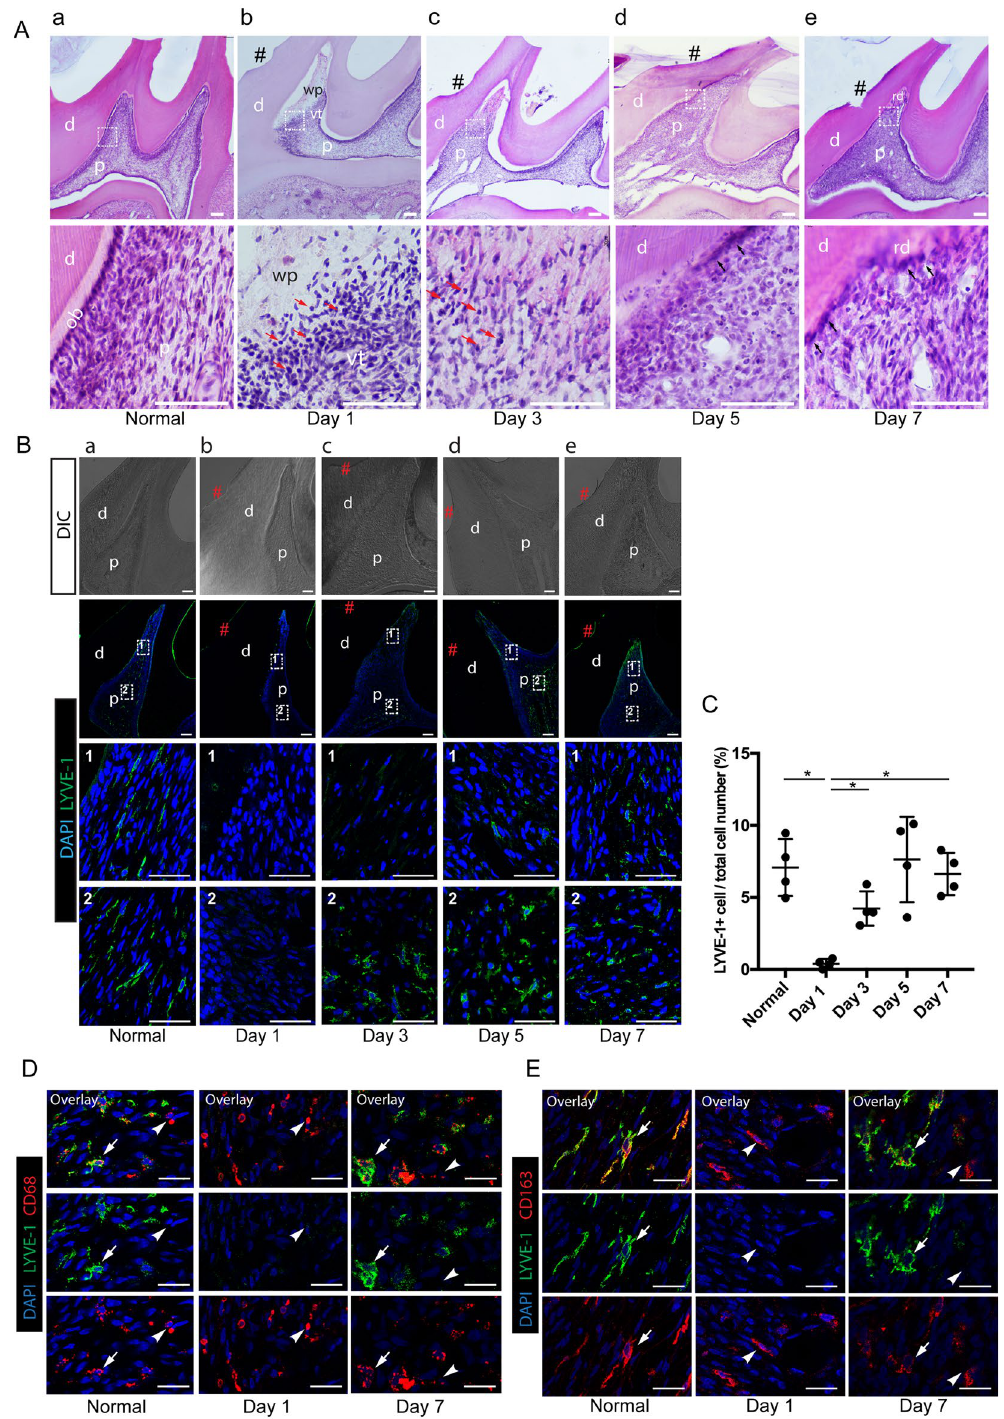
Figure 3. Distribution of LYVE-1 + cells in dental pulp after cavity preparation. ( Aa – e ) Rat molar sections at different time points after cavity preparation. Hematoxylin and eosin staining. Lower panels show a high magnification view of the boxed area in the corresponding upper panels. # indicates the cavity; red arrows, inflammatory cells; black arrows, odontoblast-like cells. ( Ba – e ) Immunofluorescence staining of LYVE-1 in rat molar sections at different time points after cavity preparation. Two regions selected for observation were: (1) the region in the mesial pulp horns beneath the cavity; and (2) the region in the mesial coronal portion distant from the cavity. # indicates the cavity. ( C ) Number of LYVE-1 + cells in the dental pulp after cavity preparation (mean ± SD). Four randomly selected representative images of the pulp tissue beneath the cavities were used for cell counting. Data were statistically analyzed by Brown-Forsythe/Welch one-way ANOVA. * p < 0.05. ( D ) Double immunofluorescence staining of LYVE-1 (green) and pan-macrophage marker CD68 (red) after cavity preparation in rat molar sections. White arrows: LYVE-1 + CD68 + macrophages, white arrowheads: LYVE-1 − CD68 + macrophages. ( E ) Double immunofluorescence staining of LYVE-1 (green) and M2-macrophage marker CD163 (red) after cavity preparation in rat molar sections. Arrows: LYVE-1 + CD163 + macrophages, arrowheads: LYVE-1 − CD163 + macrophages. Scale bar 150 µm ( A ), 100 µm ( B ), and 50 µm ( D , E ). d dentin, p dental pulp, ob odontoblast, wp wounded pulp, vp vital pulp, rd reparative dentin. Images are representative of at least 3–4 different samples for each condition